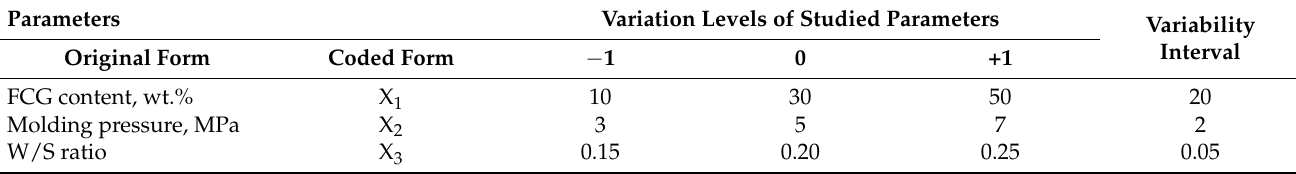
Table 5. Experiment planning conditions.